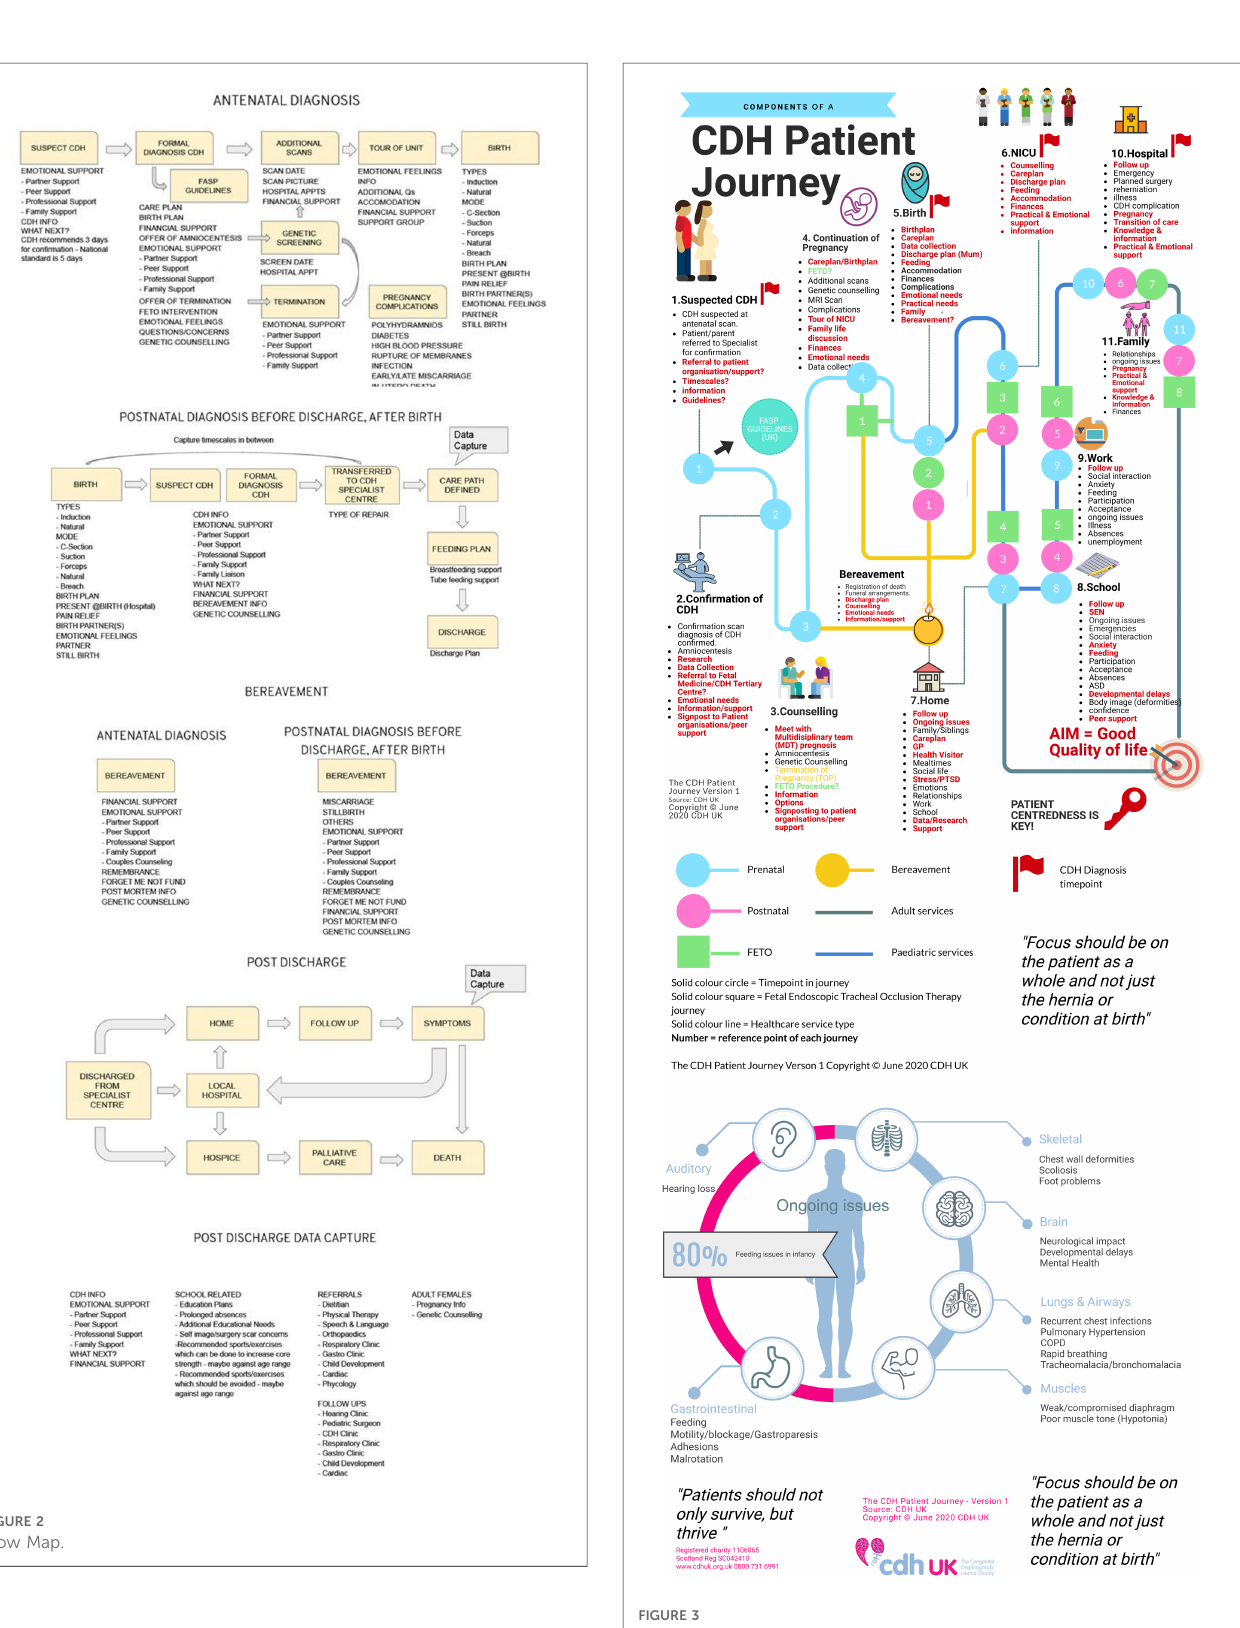
FIGURE 3 Components of a CDH patient